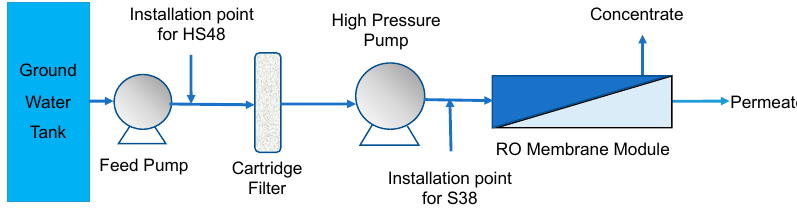
Figure 1. Schematic diagram of the groundwater desalination RO system in BGNDRF.